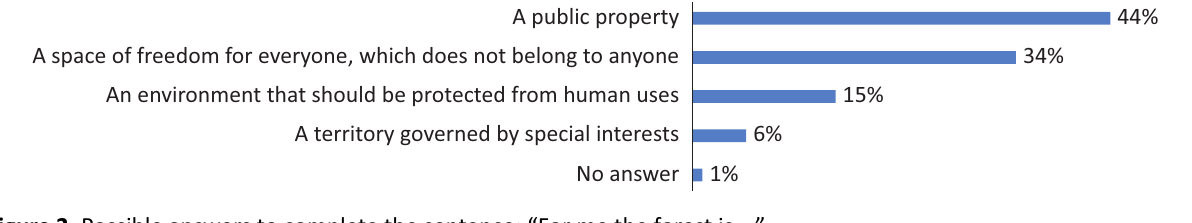
Figure 2. Possible answers to complete the sentence: “For me the forest is….”